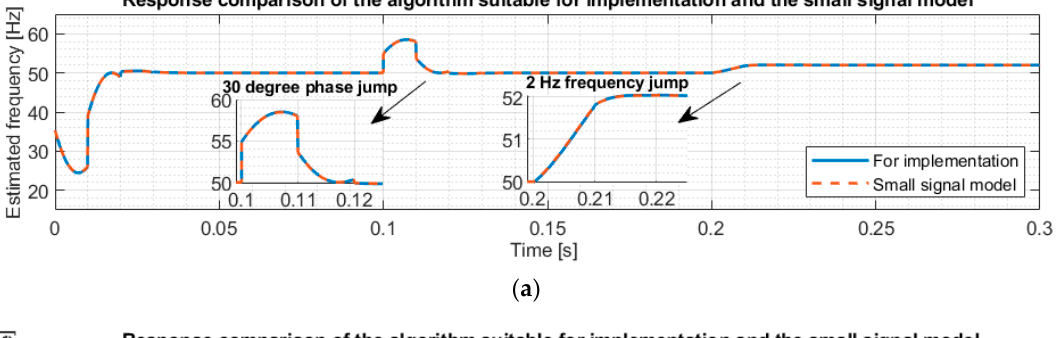
Figure 5. RCE-PLL. ( a ) Block diagram; ( b ) small-signal model; ( c ) different form of the small-signal model.